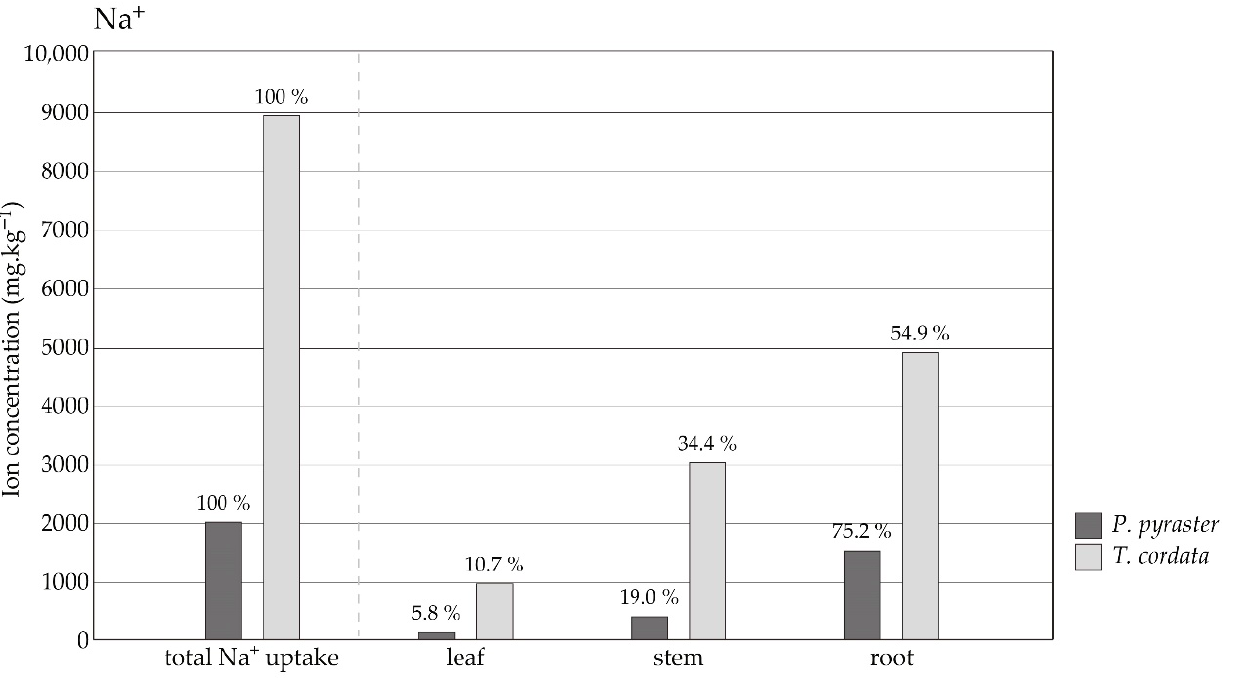
Table 3. The contents of photosynthetic pigments in the leaves of P. pyraster and T. cordata seedlings after 50 days of salt treatment. Mean values followed by different letters are significantly different.